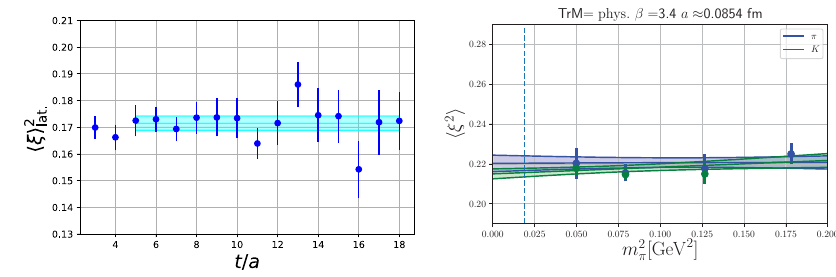
Figure 1. Left panel: example of the plateau exhibited by the ratio R + ρμν,σ ( t , p ). Momentum smearing allowed to considerably decrease the statistical noise. Right panel: example of the extrapolated pion distribution amplitude second moment as a function of the pion mass for a = 0 . 086